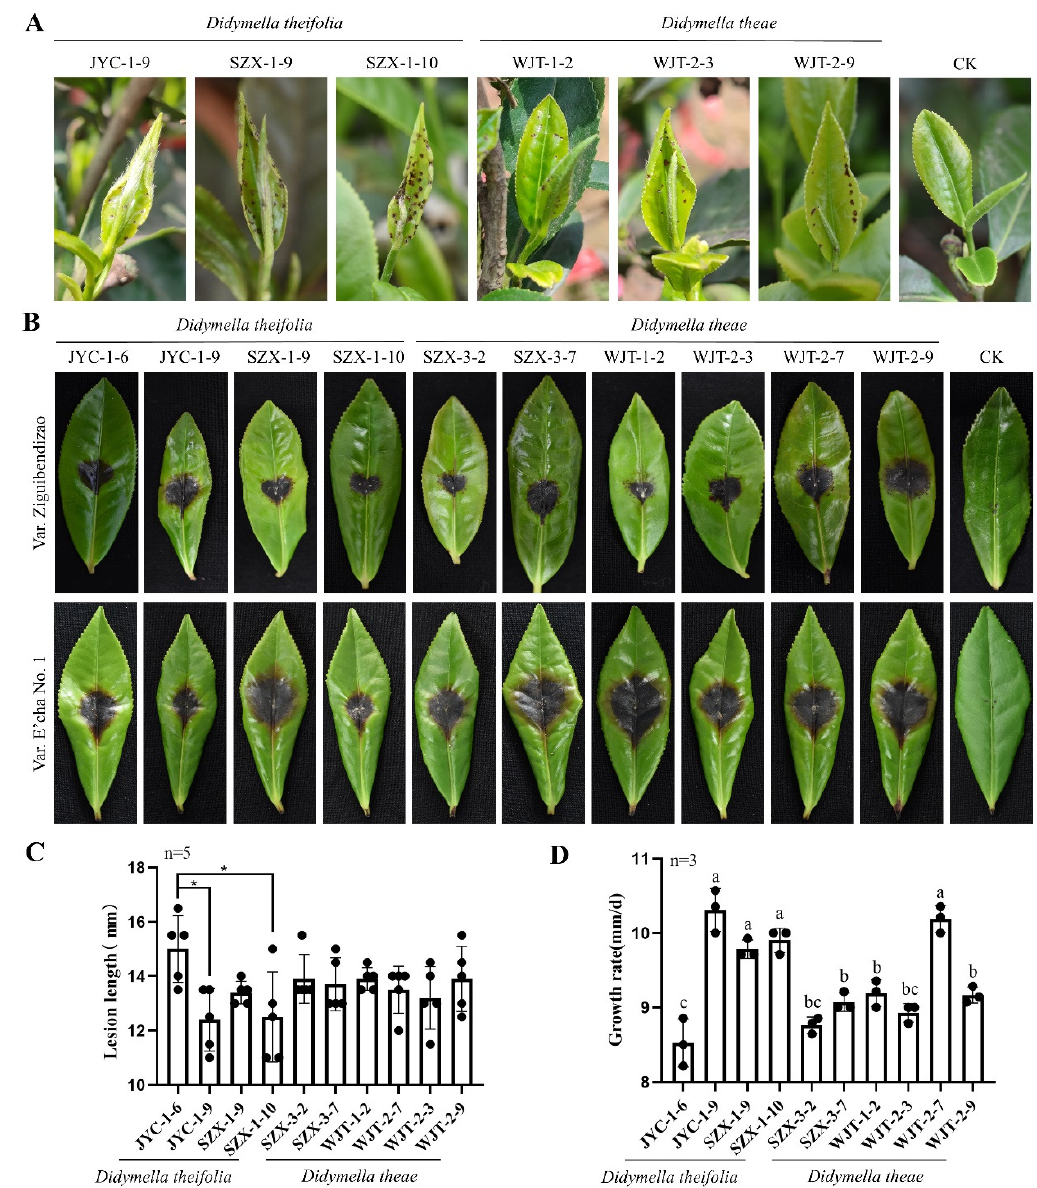
Figure 6. Virulence and pathogenicity tests and growth rates of Didymella isolates. ( A ) The representative leaf symptoms of the disease induced by the conidia solution of Didymella isolates (indicated on top of the panel) on the leaves of var. Enshitaizicha under natural field conditions. ( B ) The representative leaf symptoms of Didymella isolates on the leaves of vars. Ziguibendizao and E’cha No.1 at 4 dpi induced by mycelium discs under wounded conditions. ( C ) Bar graphs showing the virulence of Didymella isolates indicated by lesion lengths developed on tender leaves of tea (var E’cha No.1). ( D ) The growth rates of Didymella isolates in darkness at 25 °C for 7 days. The data were analyzed by SPSS Statistics 19.0 (International Business Machines Corporation, Armonk, NY, USA) using one-way ANOVA, and the mean values were compared with a Tukey test, p = 0.05. The letters and asterisks (*) on the error bars indicate the significant difference at p = 0.05.